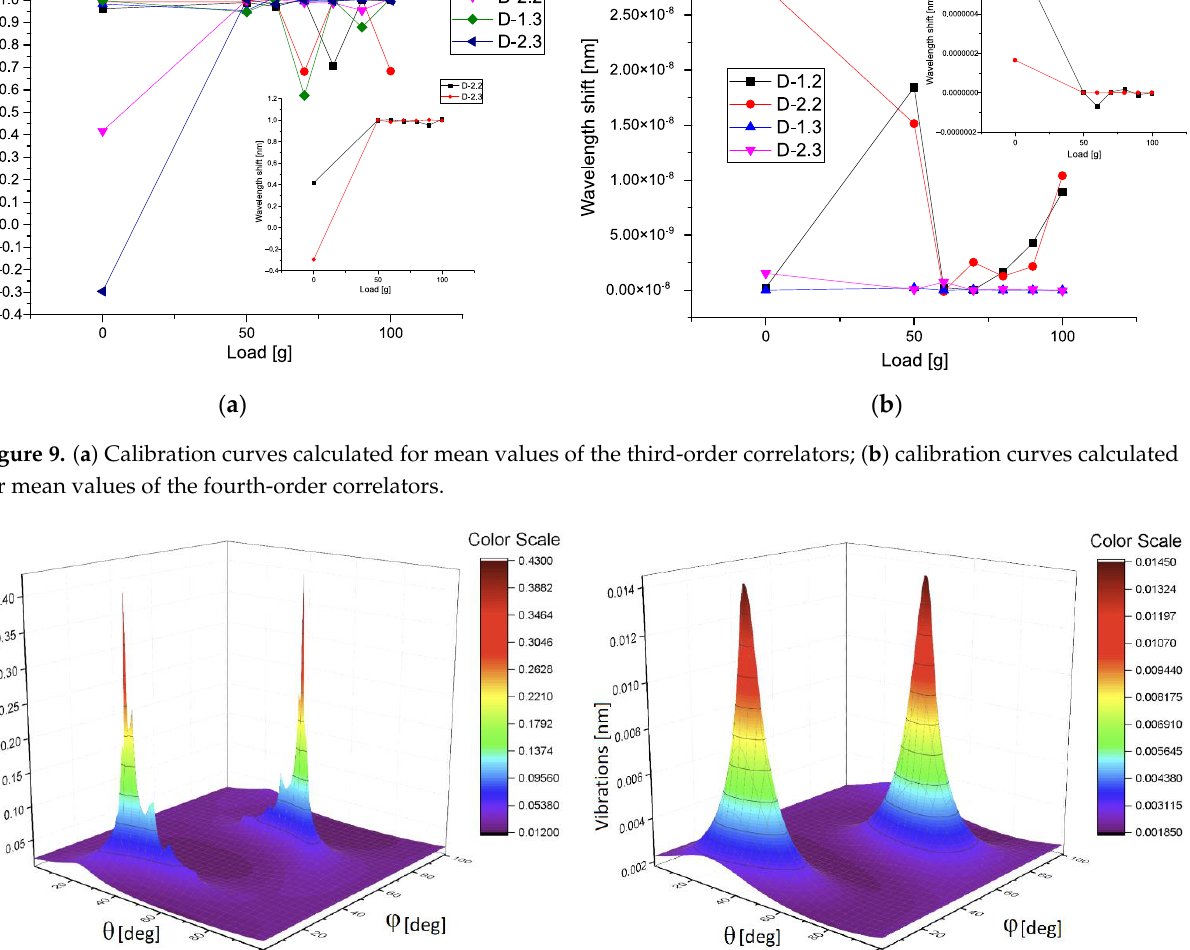
Figure 9. ( a ) Calibration curves calculated for mean values of the third-order correlators; ( b ) calibration curves calculated for mean values of the fourth-order correlators.